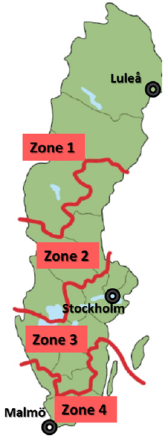
Figure 1. Swedish climate zones based on the building code of 1967.